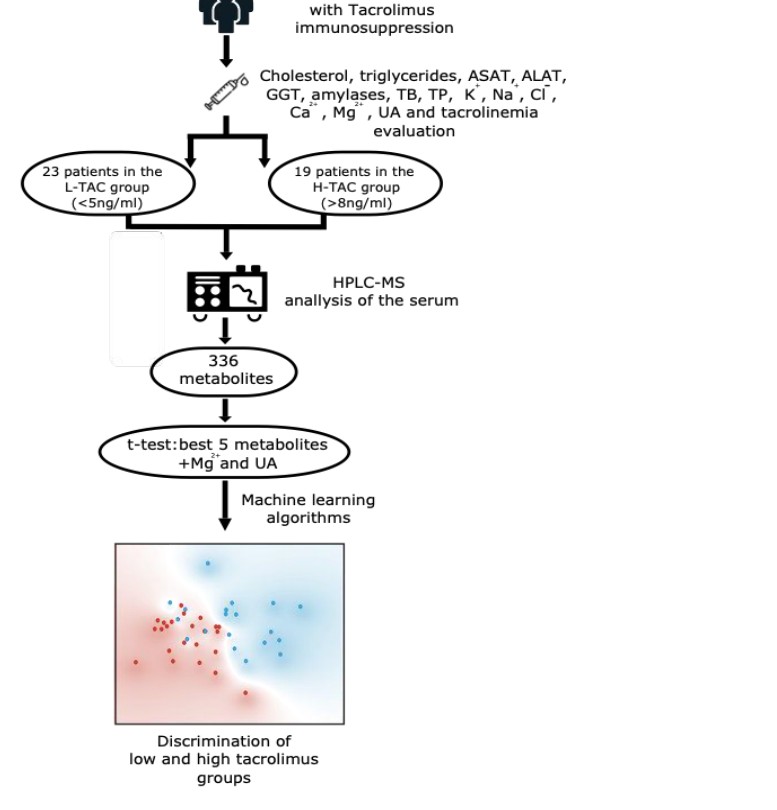
Figure 1. Workflow of the study. Abbreviations: ASAT—aspartate aminotransferase; ALAT—alanine aminotransferase; GGT—gamma-glutamyl transferase; TB—total bilirubin; TP—total proteins; K + — potassium; Na + —sodium; Cl − —chloride; Ca 2+ —ionized calcium; Mg 2+ —magnesium; UA—uric acid; L-TAC—low tacrolinemia group; H-TAC—high tacrolinemia group; UHPLC–MS—high-precision liquid chromatography – mass spectrometry analysis.